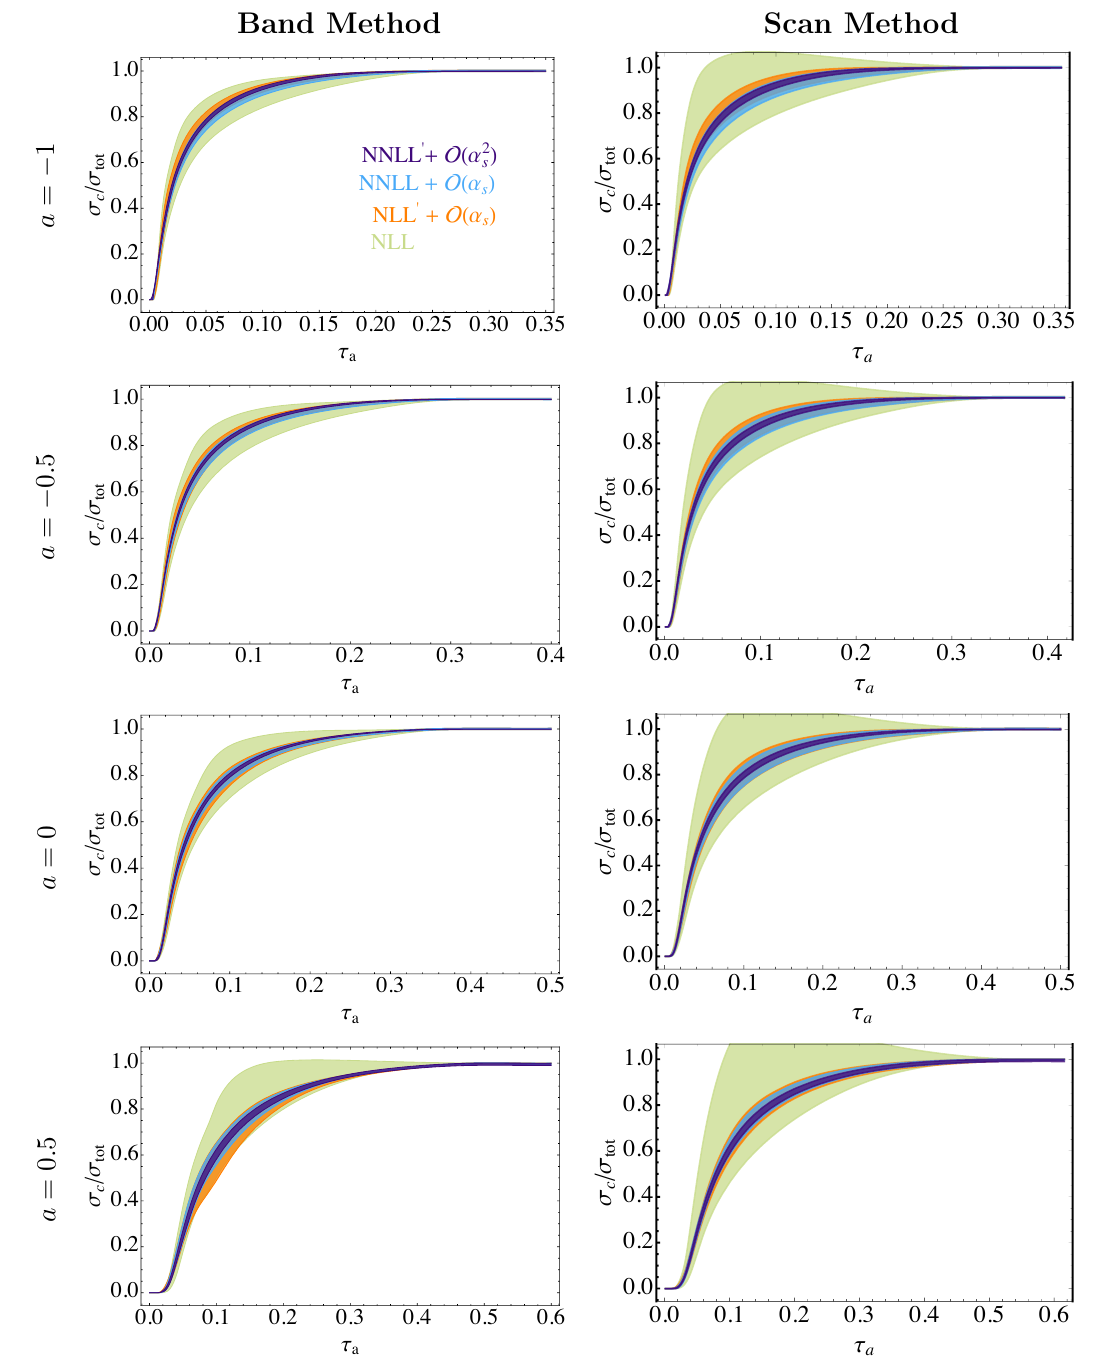
1 : 0 ; 0 : 5 ; 0 : 0 ; 0 : 5 and f(cid:0) (cid:0) g ( (cid:11) s ) (blue), and NNLL 0 + ( (cid:11) 2 ) (purple) s O O